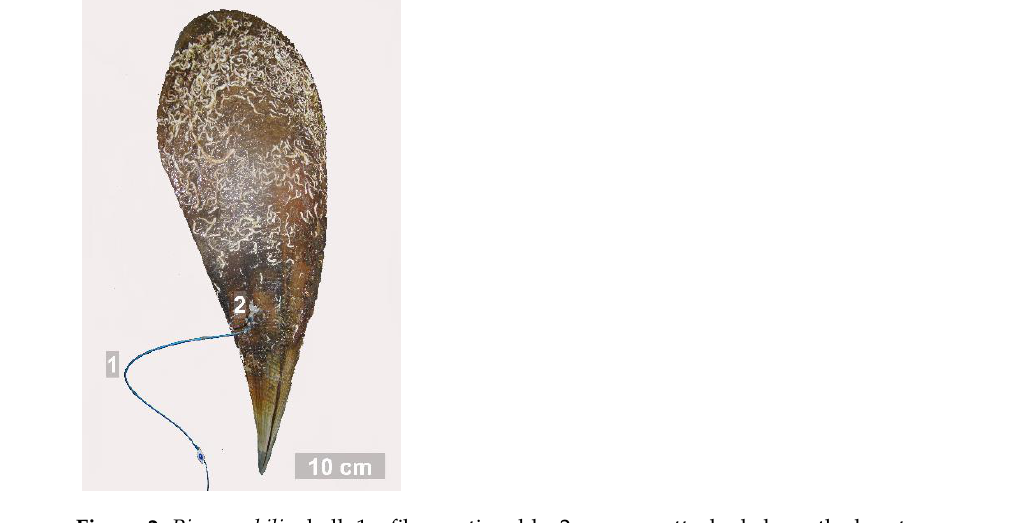
Figure 2. Pinna nobilis shell: 1 — fiber-optic cable, 2 — sensor attached above the heart area.